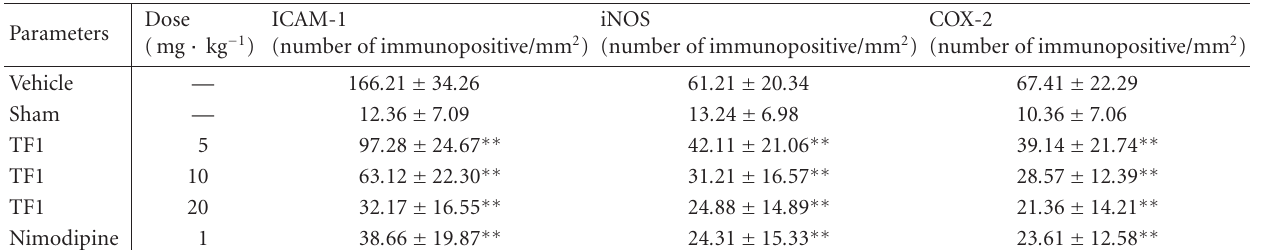
Table 2: ICAM-1, iNOS, and COX-2 protein production in vehicle and theaflavin-treated groups ( x ± s n = 10). Parameters